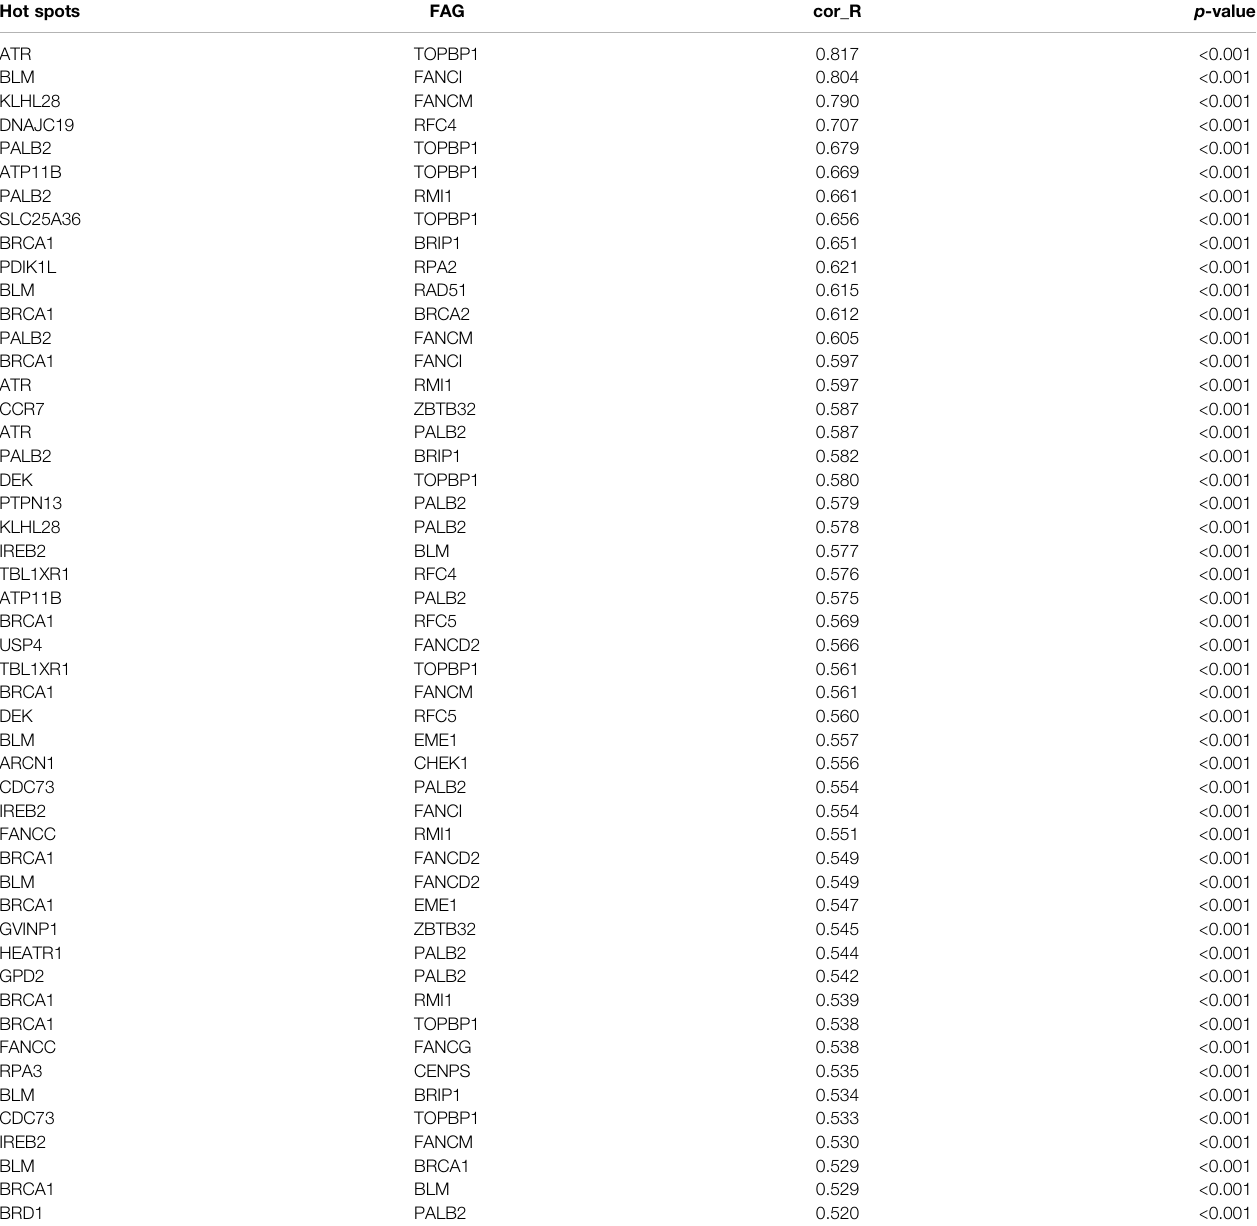
TABLE 2 | Correlation between HPV integrated heat gene and FARGs (Top